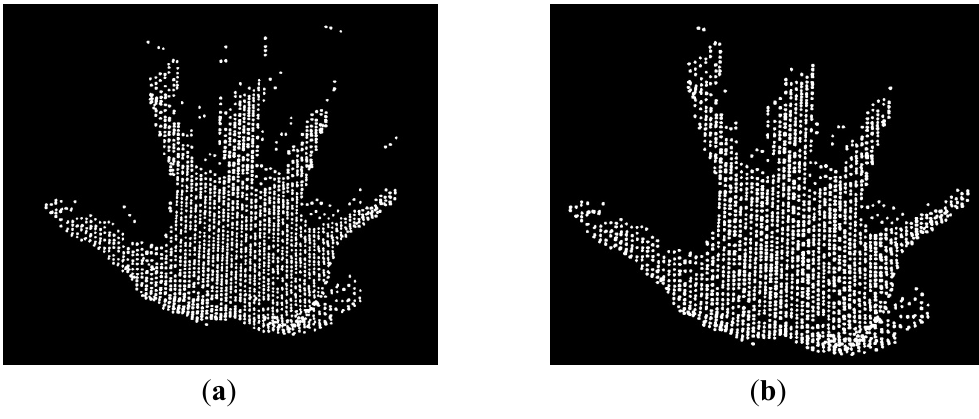
Figure 6. Remaining noise removal. Before using the connected component analysis ( a ); after using the connected component analysis ( b